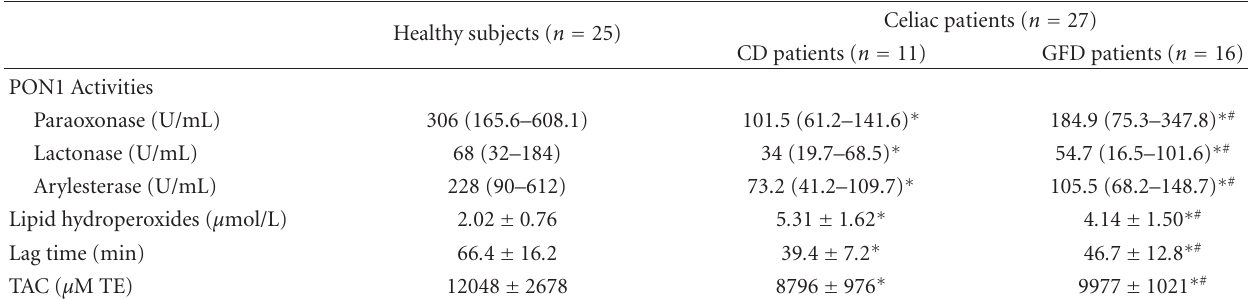
Table 2: PON1 activities, markers of lipid oxidative stress (levels of lipid hydroperoxides and lag time of conjugated dienes) and total antioxidant capacity (TAC) in serum of healthy subjects, celiac patients at diagnosis (CD patients), and celiac patients treated with a gluten- free diet (GFD patients). Data are given as median (range) for paraoxonase activities and means ± S.D. for other biochemical parameters.